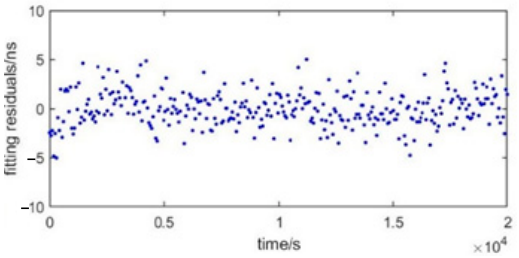
Figure 9. RDSS two-way timing error (remove orbit period).